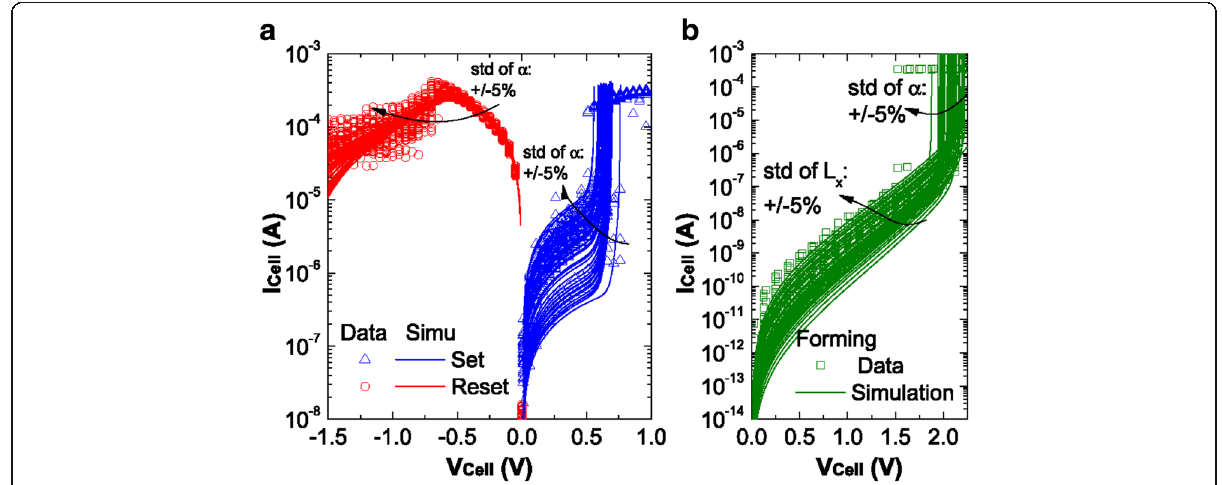
Fig. 12 a , b Experimental I (V) characteristics for Electroforming , Set , and Reset processes measured on a large number of memory elements to understand the device-to-device variability. The experimental device-to-device variability is accounted for in Monte Carlo simulations with a ± 5% standard deviation on parameters α and L x